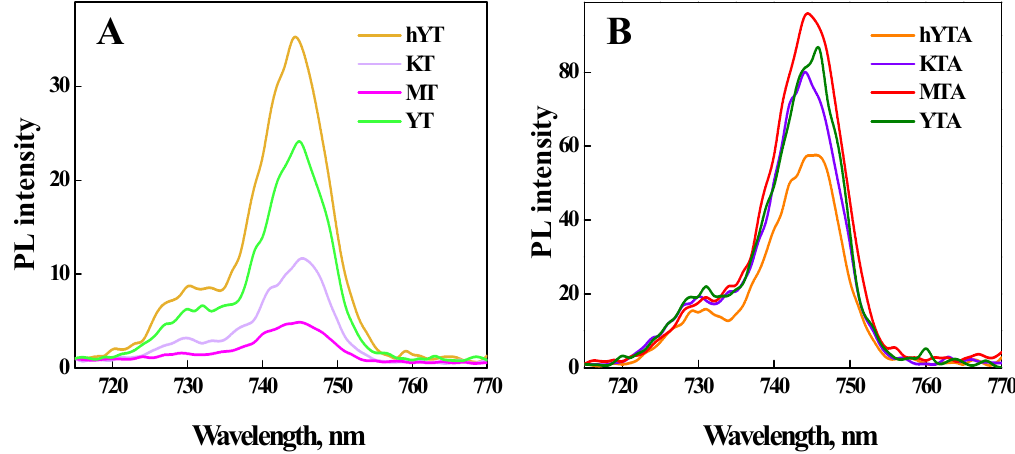
Figure 7. The PL spectra of Ti-modified materials ( A ) and Au-Ti photocatalysts ( B ).